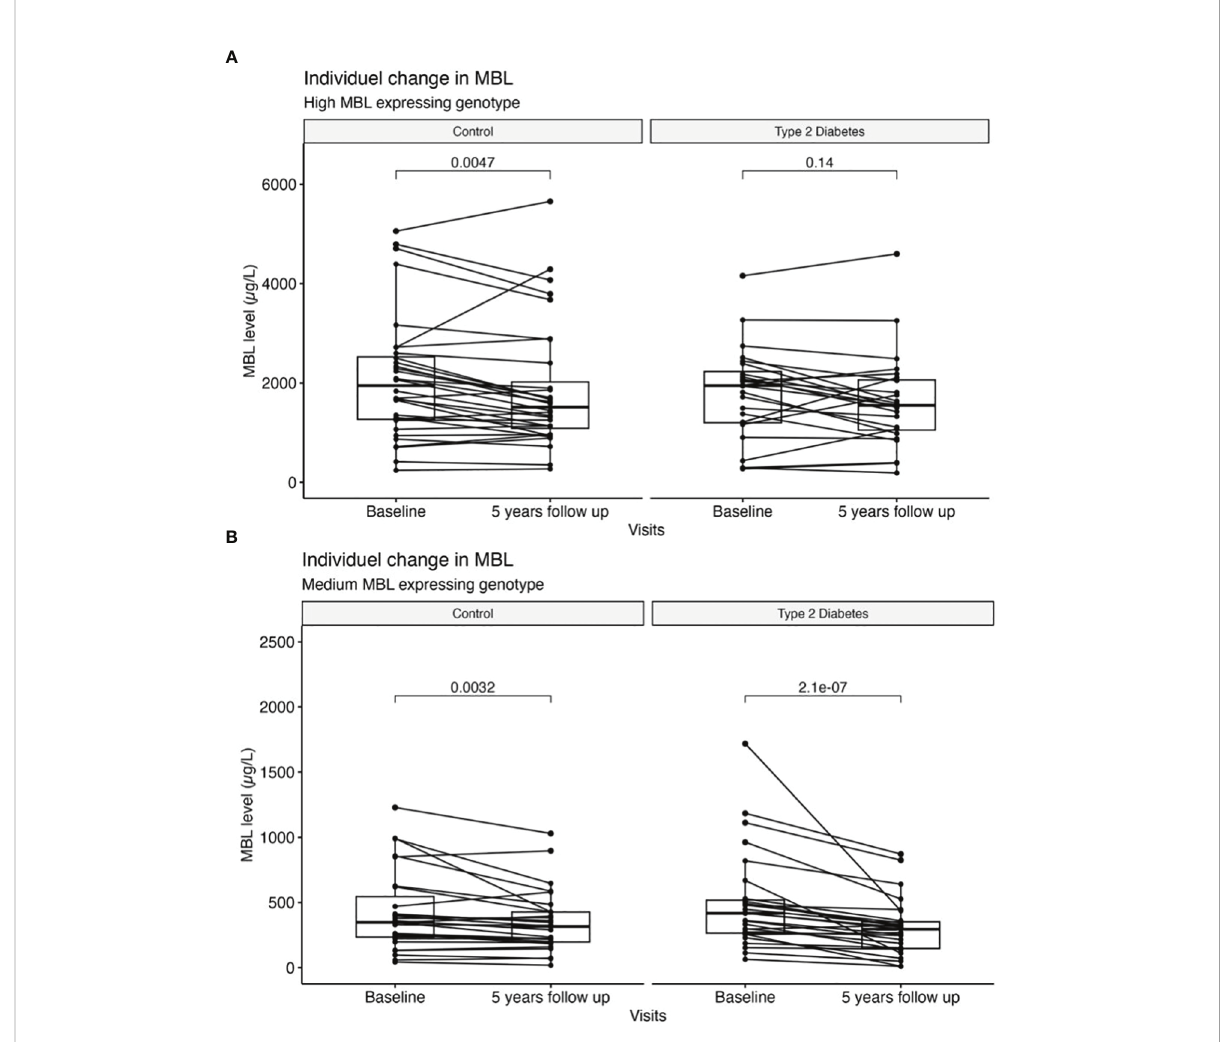
FIGURE 2 Individual change in serum levels of MBL between baseline and 5-year follow-up. (A) High MBL expressing genotypes and (B) medium MBL expressing genotypes are divided according to diabetes status. Bars represent medians, and boxes indicate IQRs. P-values are calculated with the Wilcoxon signed-rank test for differences between